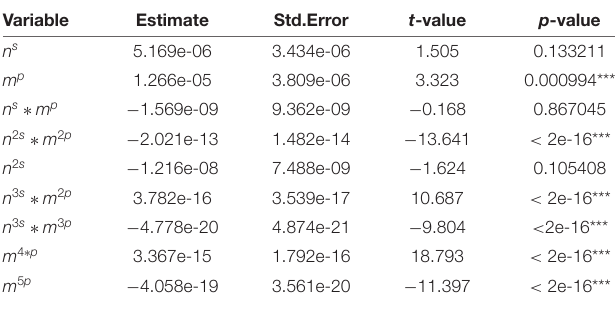
TABLE 2 | Summary statistics for selected variables in interval sample size < 50.